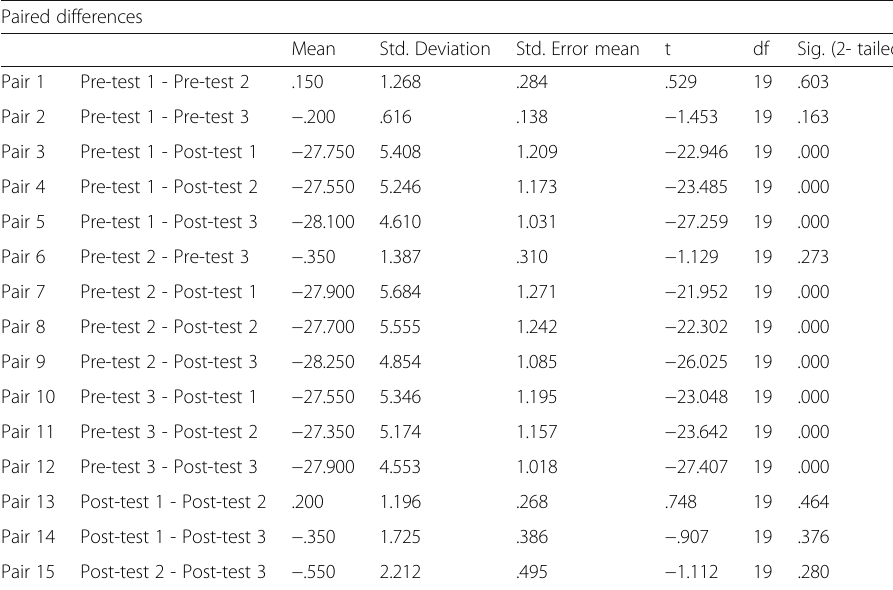
Table 3 Paired samples